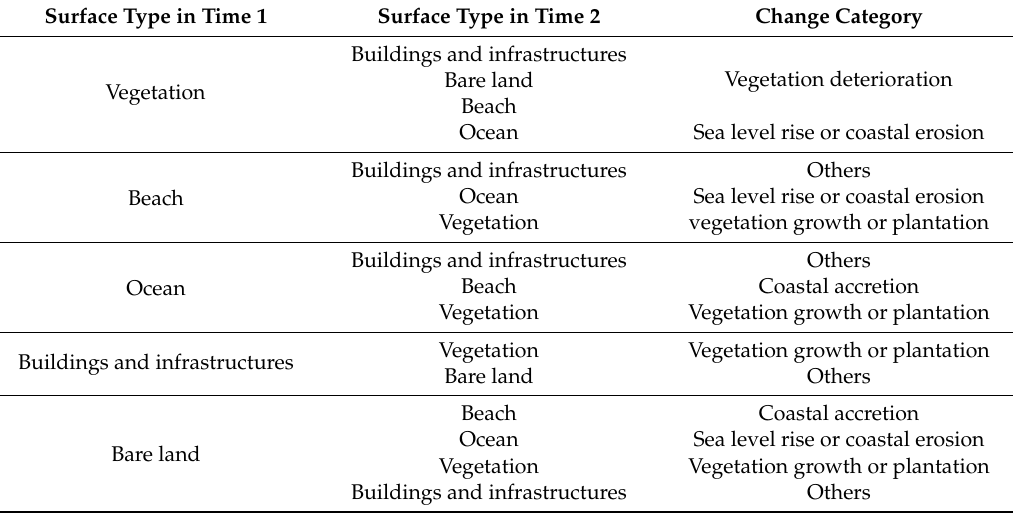
Table 2. Change category definition of Zhongye Island and Taiping